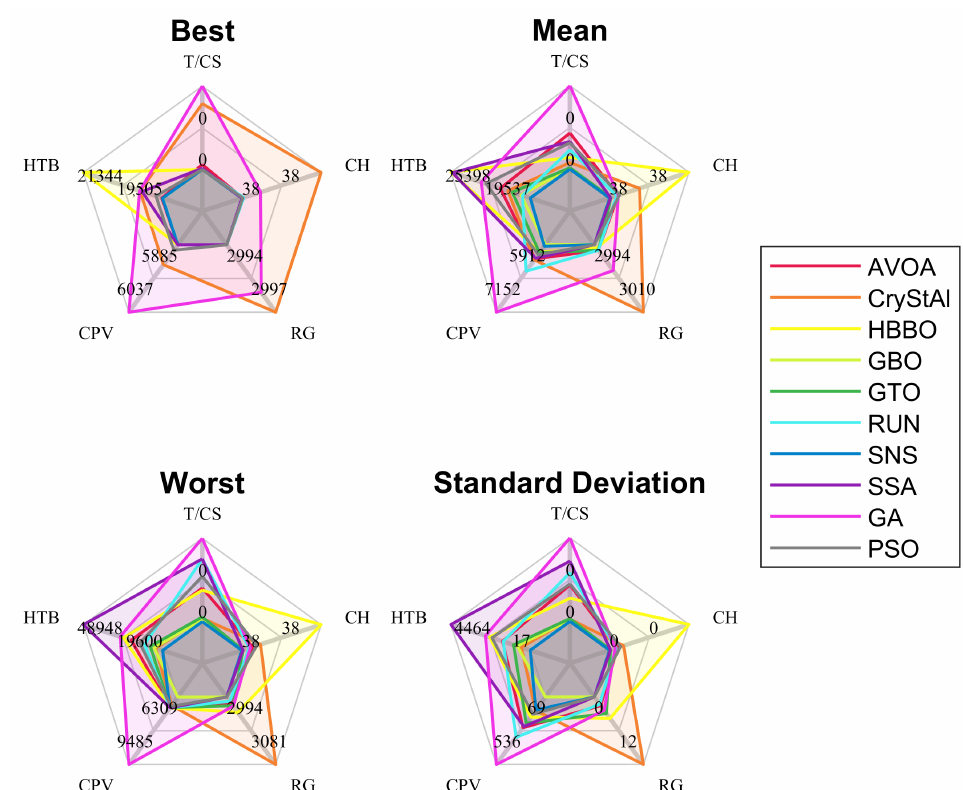
Figure 11. A spider plot comparison of eight recent and two widely used (i.e., GA and PSO) population-based metaheuristic optimisation techniques was undertaken on the five component design problems. Please remember that smaller values indicate better performance. The annotations are as follows: T/CS, tension/compression spring; CH, crane hook; RG, reduction gear; CPV, cylindrical pressure vessel; HTB, hydrostatic thrust